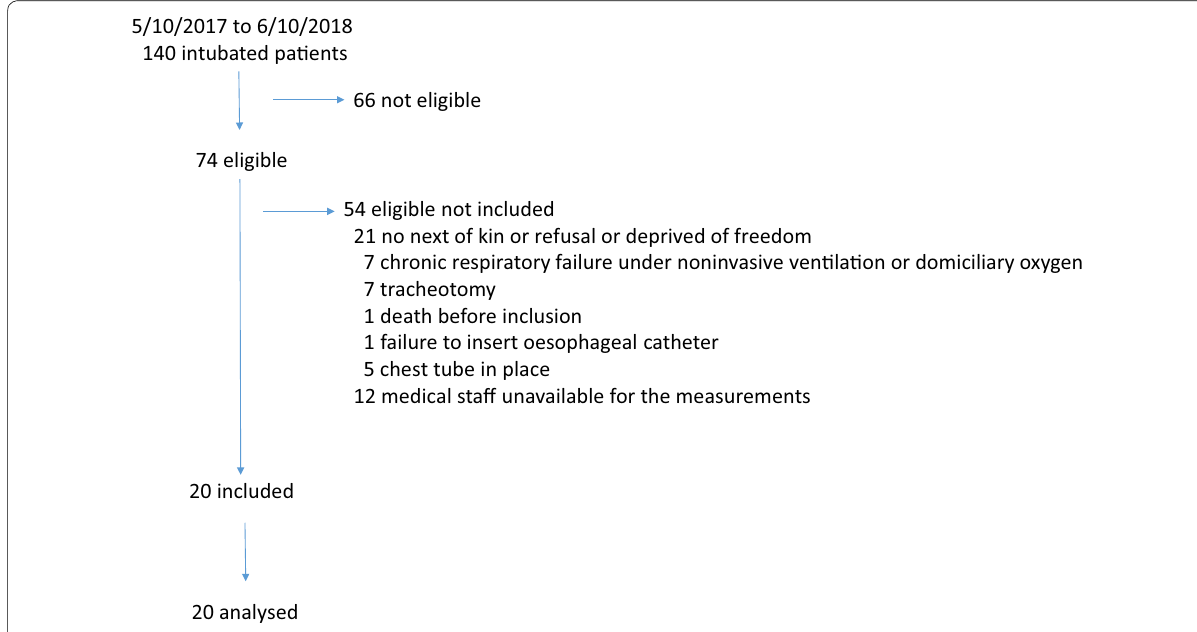
Fig. 2 Flowchart of the patients during the study